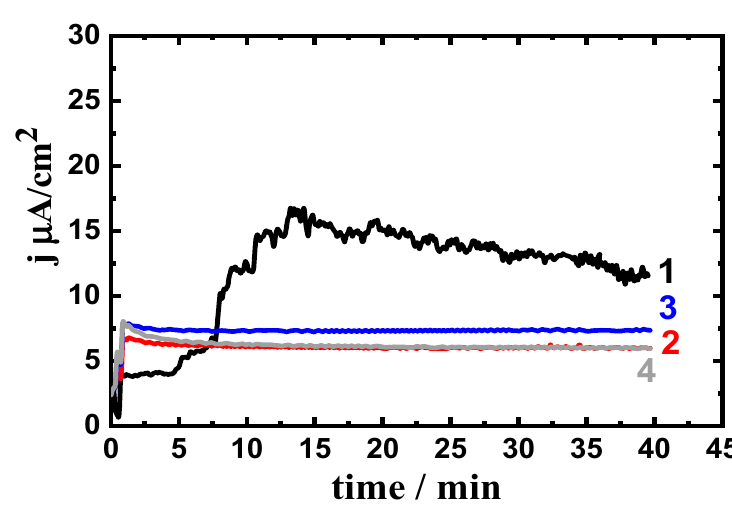
Figure 9. Current–time curves collected at 0.30 V (Ag / AgCl) for (1) Ti6Al2V, (2) Ti6Al4V, (3) Ti6Al6V, and (4) Ti6Al8V alloys after 24 h immersion in 3.5% NaCl solution, respectively.